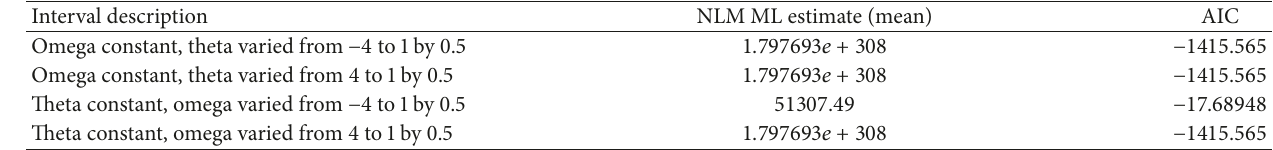
Table 15: Summary of results for lambda = 0.8, 𝑛 = 10 𝑖 , 𝑖 = 6 .